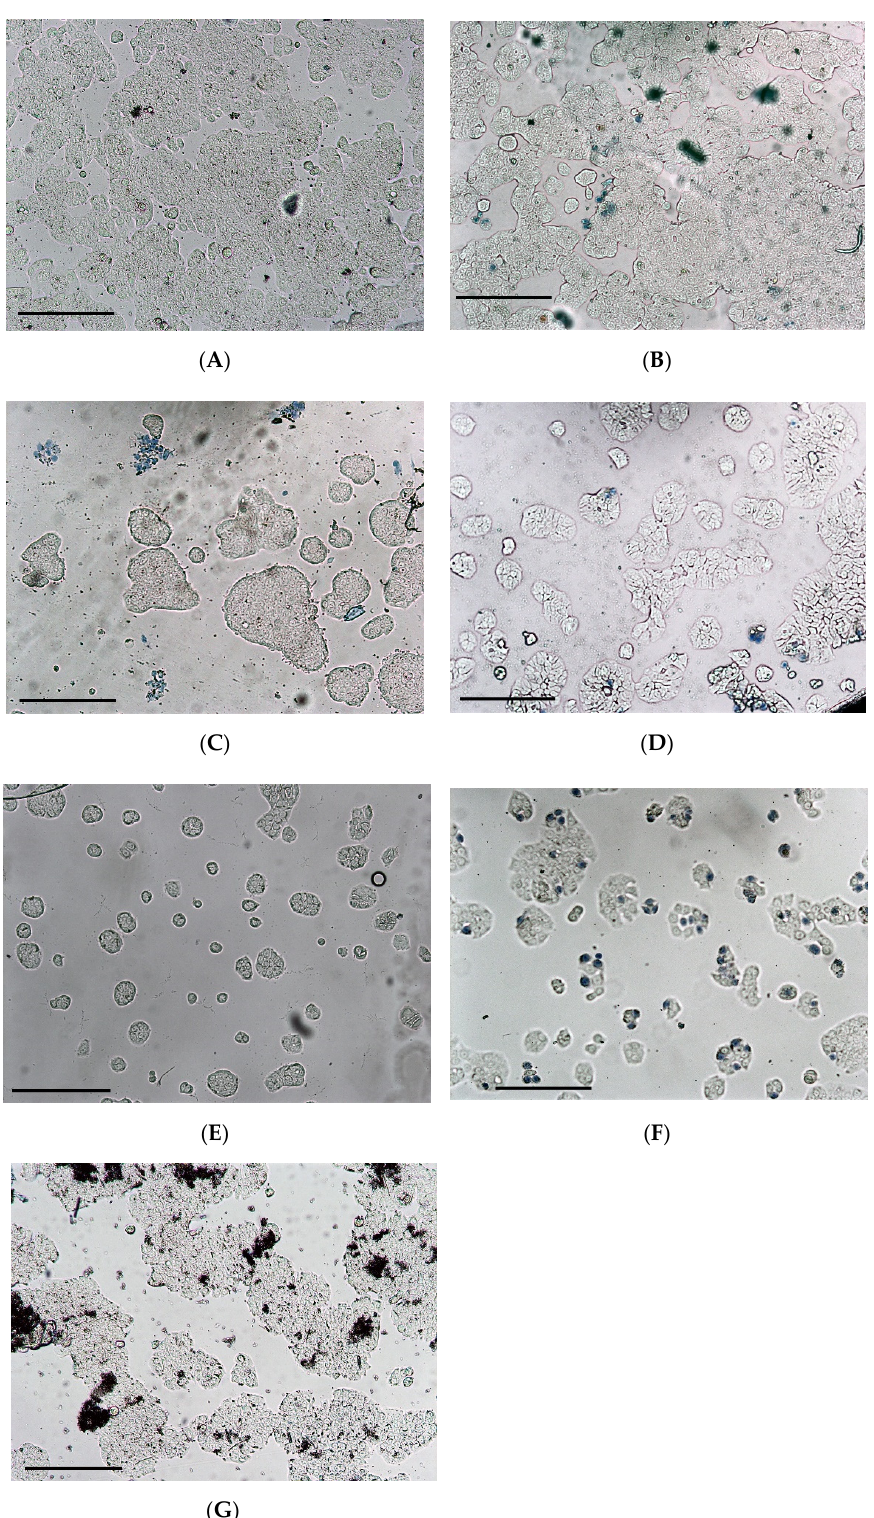
Figure 4. Trypan blue staining of HT-29 cells exposed for 24 h with different Aloe-samples: Control ( A ), 1× DAG60 ( B ), 0.3× DAG80 ( C ), 1× PAG80 ( D ), 1× AAG80 ( E ), 0.3× ILF ( F ) and 3× AILF ( G ). Initial confluence was ~80% in all cases; frequently not many blue stained (dead) cells can be seen as those are washed away in a previous washing step (confluence can be evaluated). The bar indicates 50 µm.